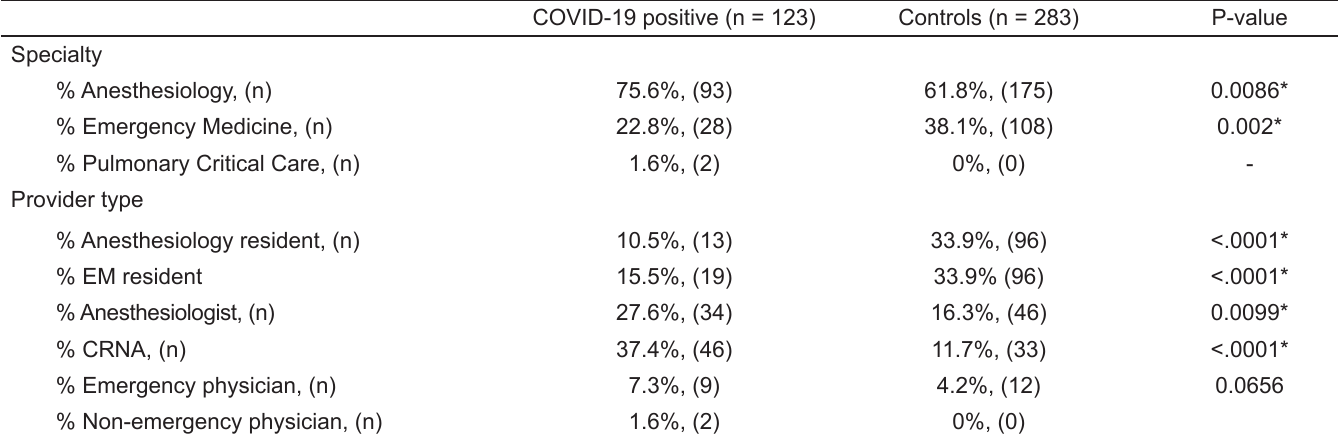
Table 2. Provider characteristics associated with COVID-19 compared with controls. An asterisk indicates where α < 0.05.